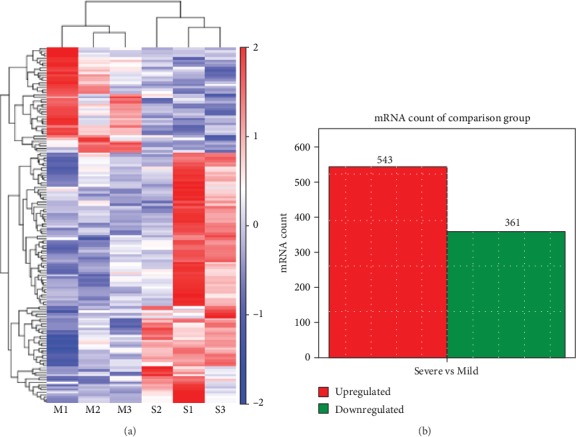
Overlapping genes from the predicted miRNA targets and differentially expressed mRNAs. (a) Hierarchical cluster analysis of overlapping genes. (b) mRNA counts of upregulated and downregulated overlapping genes. Mild: children with mild RSV-associated pneumonia; Severe: children with severe RSV-associated pneumonia. M1, M2, M3, S1, S2, and S3 are the same patients as in Figure 3.